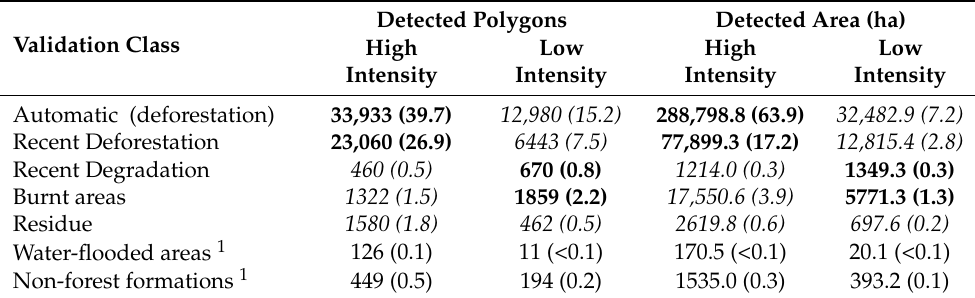
Table 2. Validated warnings between 21 April 2021 and 20 April 2022.The values in percentage are given in